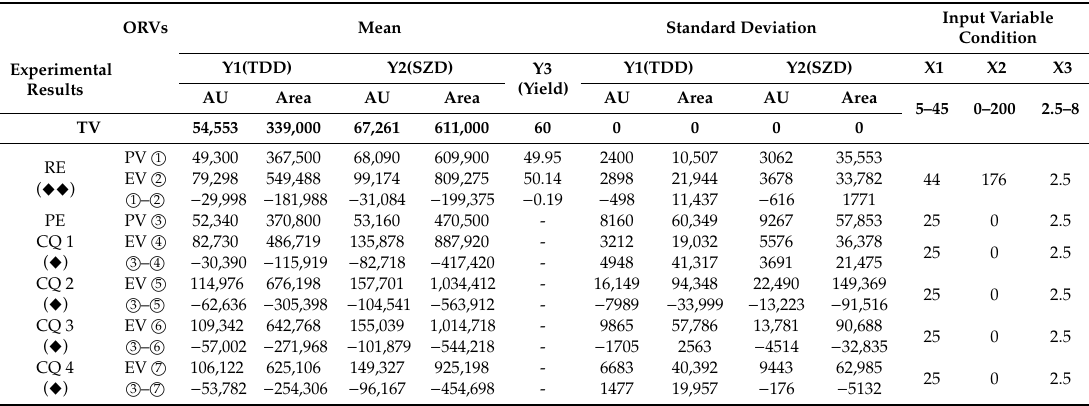
Table 8. Reproducibility and previous experiment (PE)